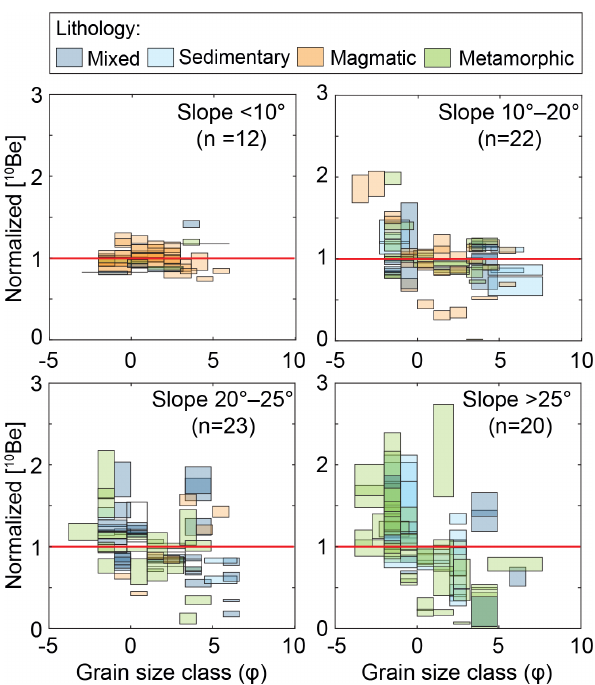
Figure 7. All global compilation samples divided into mean basin slope classes and colour coded by lithology. The boxes indicate nor- malized mean 10 Be concentrations ( ± analytical errors) and the phi- grain-size range. The 10 Be concentrations are normalized by the arithmetic mean 10 Be concentration of all samples from the same